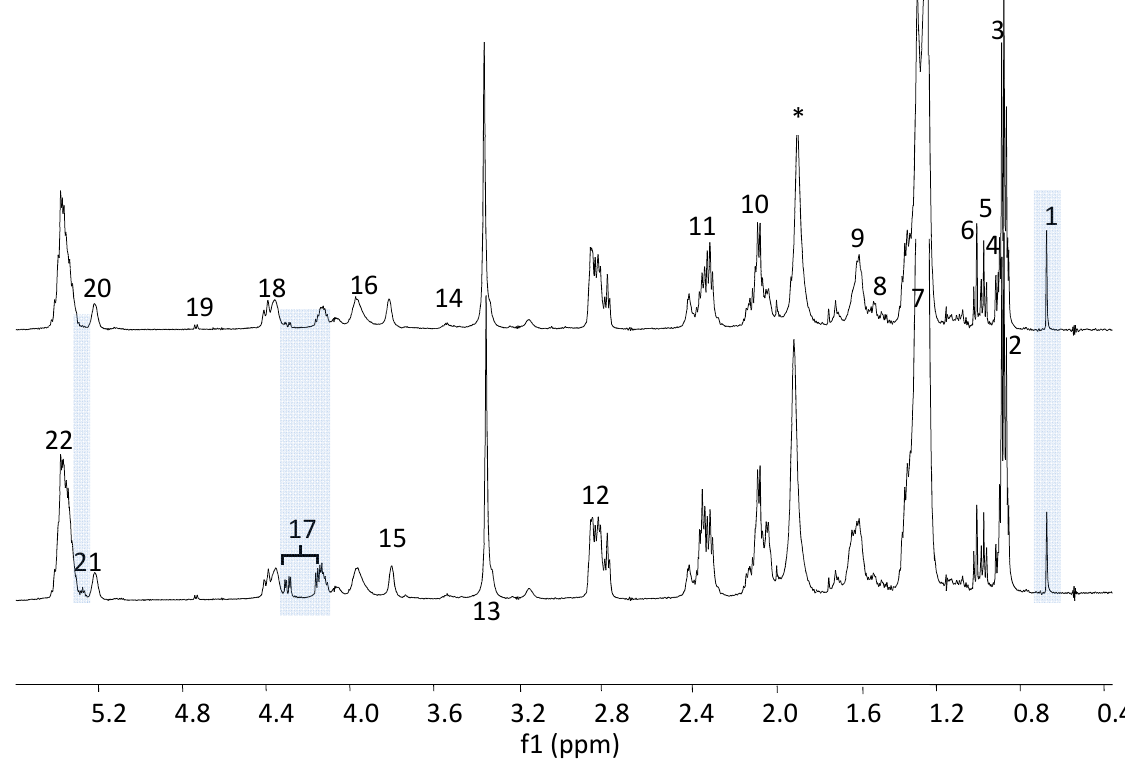
Figure 2. 1 H-NMR Spectra of Lipid Metabolites, Bottom: Control; Top: